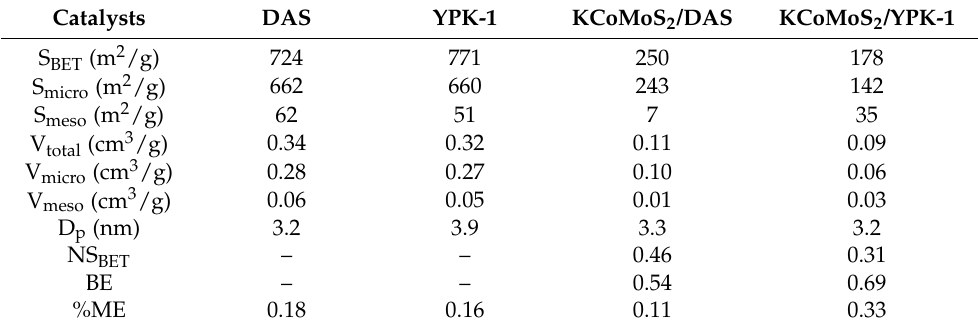
Table 1. Surface area and pore characteristics for AC-supported KCoMoS 2 catalysts 1 .